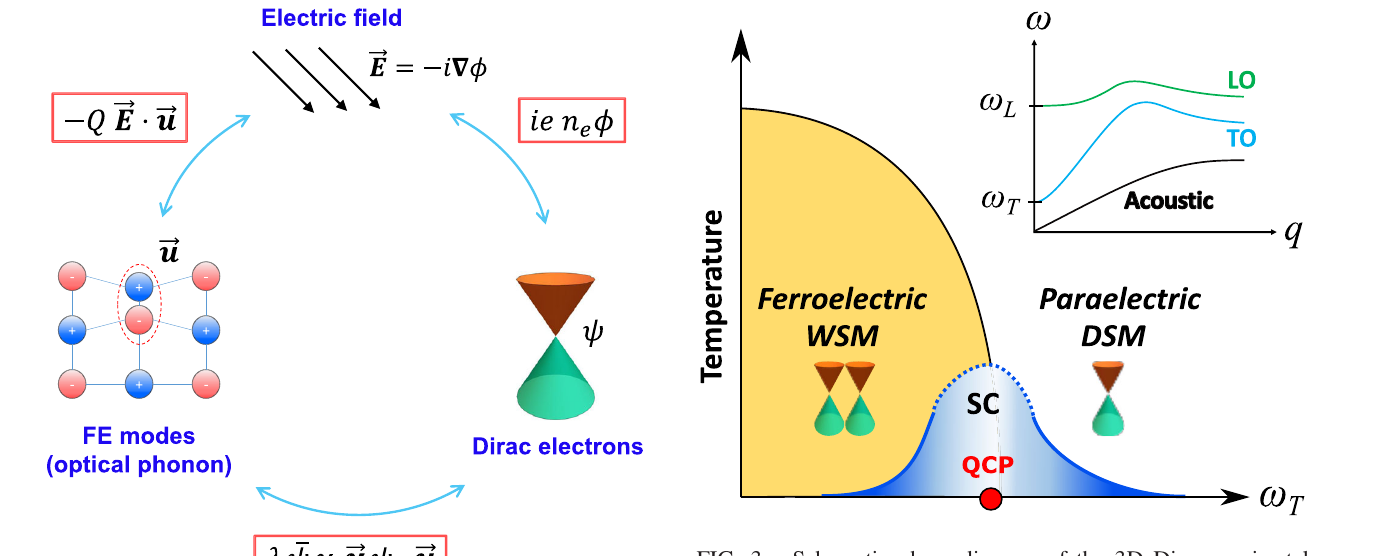
FIG. 3. Schematic phase diagram of the 3D Dirac semimetal (DSM) near a FE QCP. The FE QCP separates the inversion- symmetric DSM and inversion-broken Weyl semimetal (WSM) phases. Upon approaching the phase transition (controlled by ω T ), there is a region where we predict superconductivity at an ultralow density (blue dome). Because of the long-ranged dipolar forces between LO modes, close to the FE QCP, only the TO modes soften, as shown in the inset (the LO-TO splitting). We consider the direct coupling of these TO modes to the Dirac fermions through spin-orbital effects. RG analysis shows that this coupling is a relevant perturbation that renders the Dirac point unstable at a low energy. We find that this type of QCP combines two ingredients which are essential for superconductivity at a low density: (i) strong attraction that compensates a small density of states and (ii) screen- ing of the Coulomb repulsion between electrons by the LO modes. The dashed line denotes the region of strong coupling in the immediate vicinity of the critical point where our weak-coupling analysis breaks